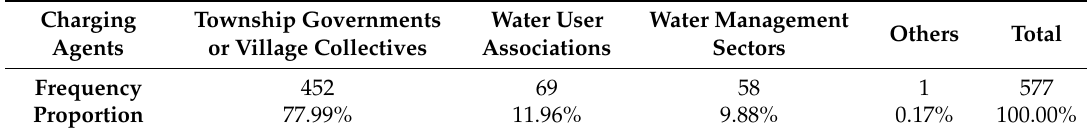
Table 5. Statistics for agents charging AWF in the sampling